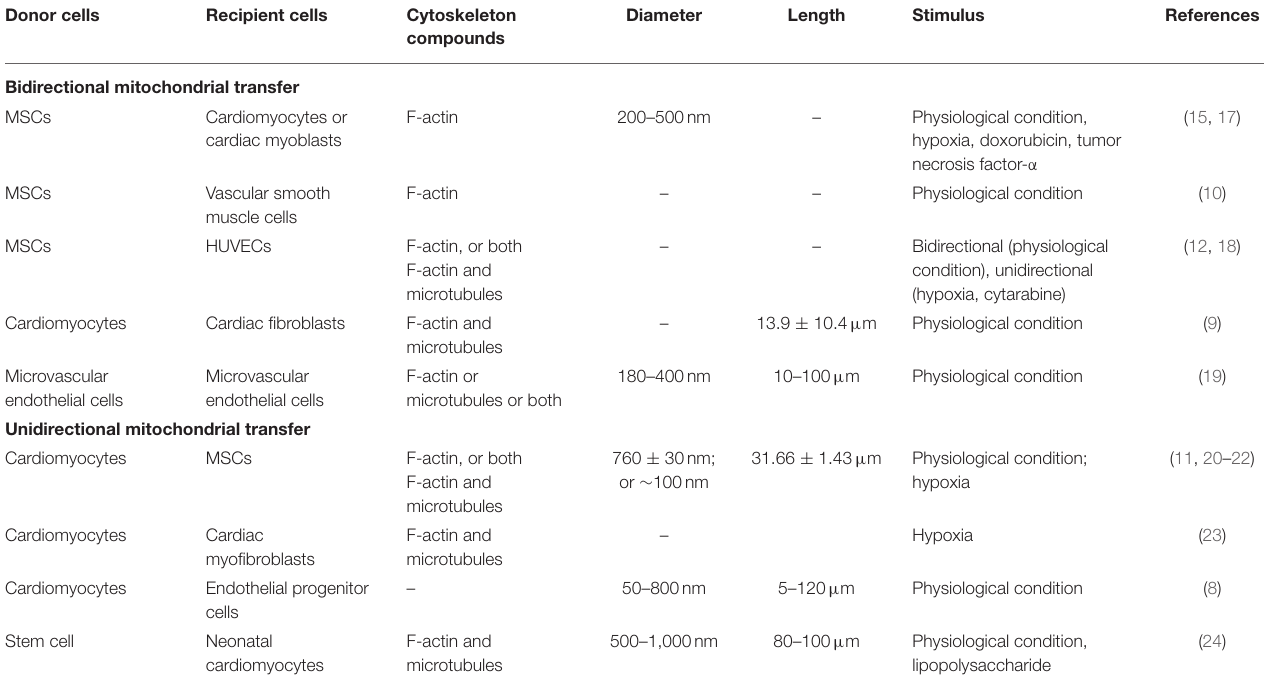
TABLE 1 | Properties of mitochondrial transfer-related TNTs in cardiovascular